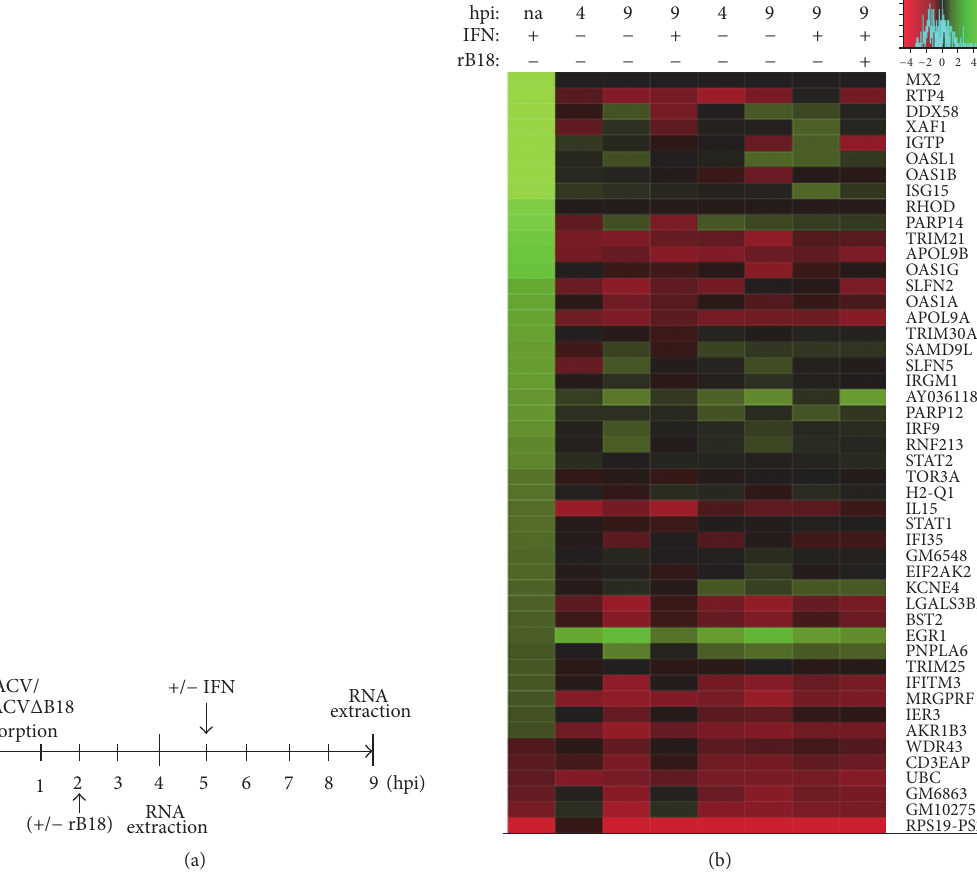
Figure 5: ISGs expression during VACV infection. (a) Diagram showing the experimental conditions to obtain RNA samples from infected cells. (b) Heatmap shows the expression levels of the ISGs previously identified relative to untreated cells, where indicated recombinant B18 protein (rB18) and/or mouse IFN 𝛼 were/was added to cells at 2 and 5 hpi,